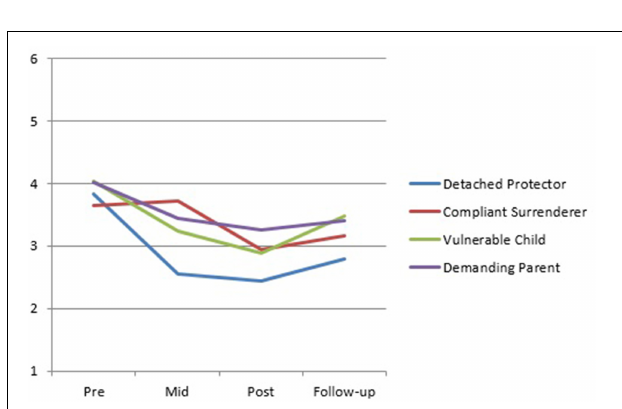
FIGURE 2 | SMI maladaptive modes group means from pre-treatment through mid-, post-, and follow-up.